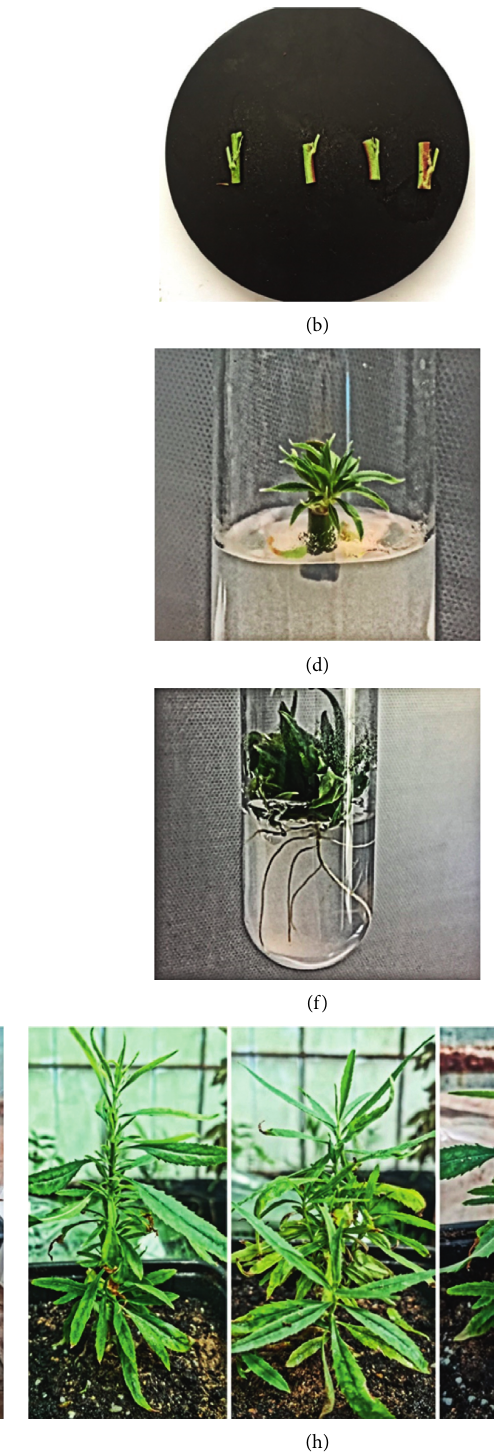
Figure 1: In vitro culture of nodal segments from “Beldi” almond ecotypes. (a) Young branch taken from adult almond tree. (b) 4 uninodal herbaceous cuttings. (c) Uninodal segment culture on MS medium supplemented with 1mg/L BAP+0.5 mg/L IBA. (d) Actively growing shoots. (e) Shoots elongation in hormone-free MS medium. (f) Formation of roots from regenerated shoot cultured on half-strength MS medium supplemented with 1mg/L of IBA. (g) Healthy plantlets transferred to pot filled with a mixture of perlite, sand, and soil (1:1 :1) after 2 weeks of acclimatization. (h) Plantlets placed in a greenhouse successfully adapted to the in vivo